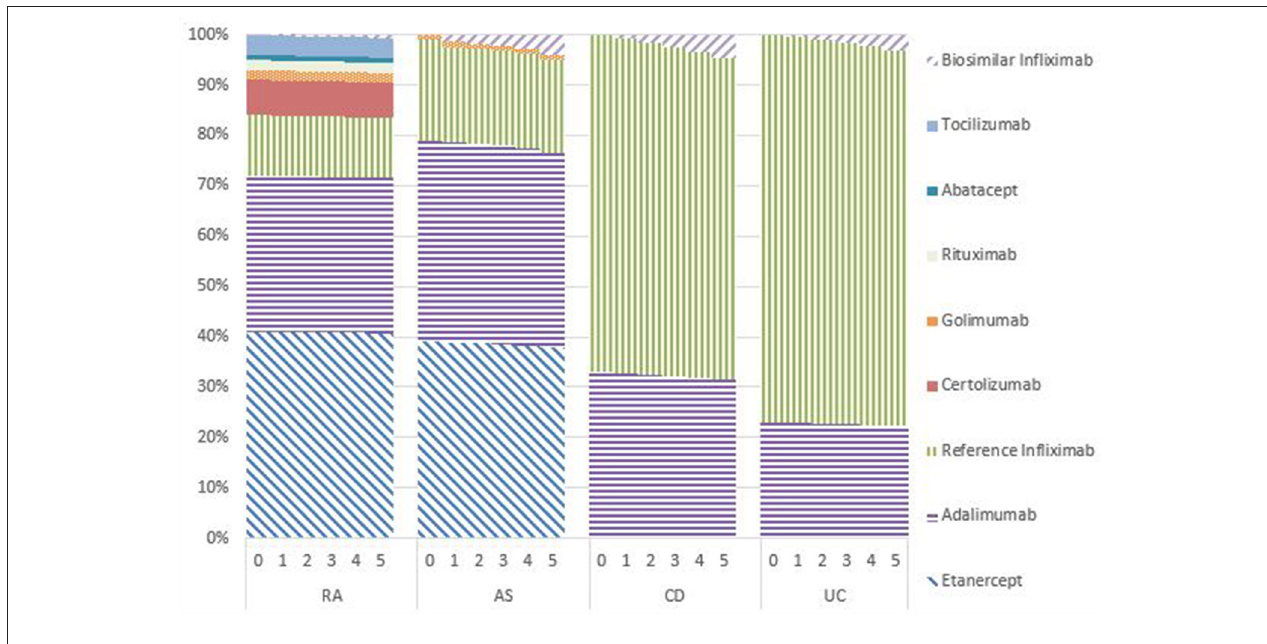
FIGURE 3 | Market shares biologics France in years 0–5.